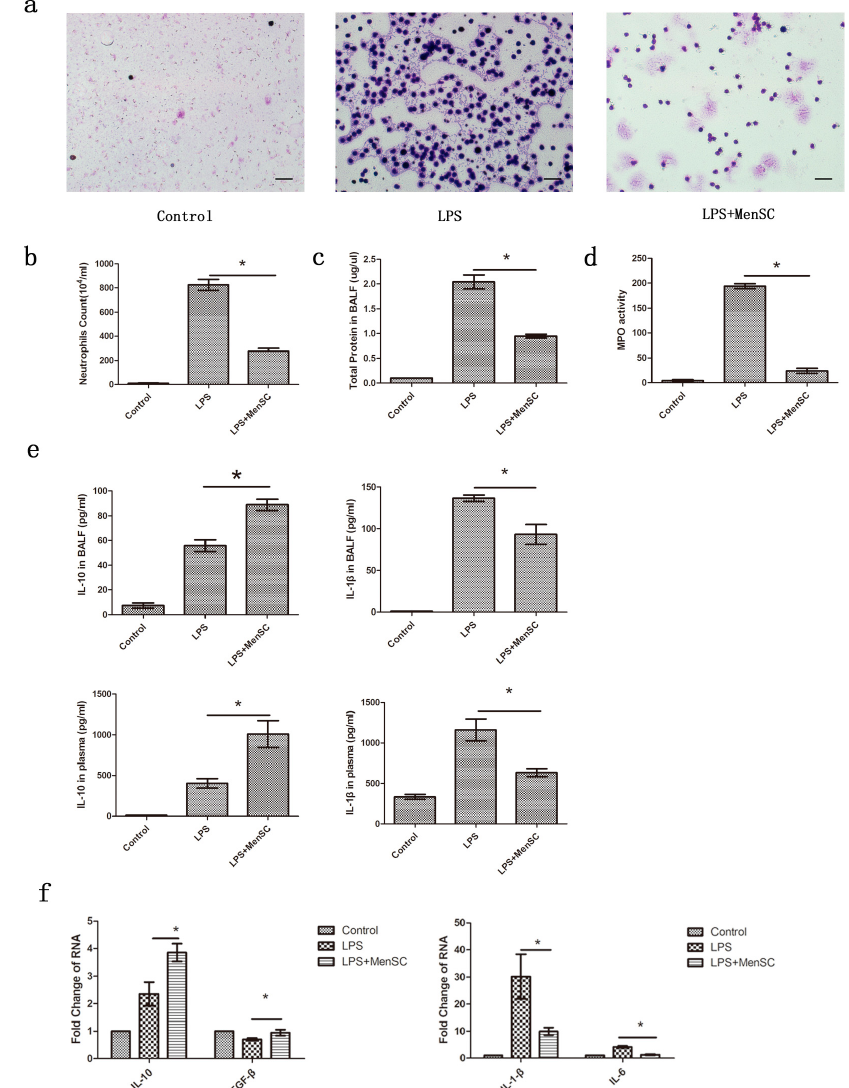
Figure 6. MenSCs attenuate the inflammation of ALI. ( a , b ) inflammatory cells in the BALF were observed by cell smears (Wright-Giemsa staining) and counts; ( c ) The total protein in the BALF; ( d ) MPO activity in the BALF; ( e ) IL-10 and IL-1 β protein levels in the BALF and plasma; ( f ) Expression levels of IL-10, TGF- β , IL-1 β and IL-6 in the lung. * p < 0.05. Scale bar: 50 µm.